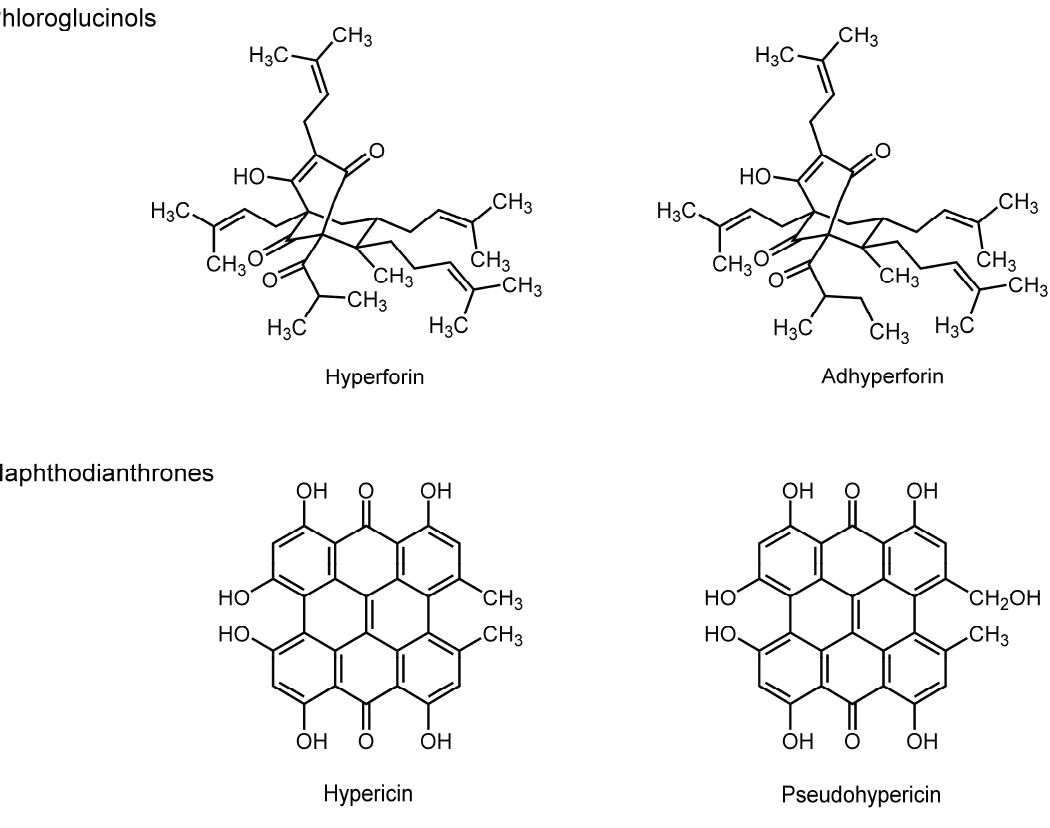
Figure 5. Structures of membrane-interactive phloroglucinols and